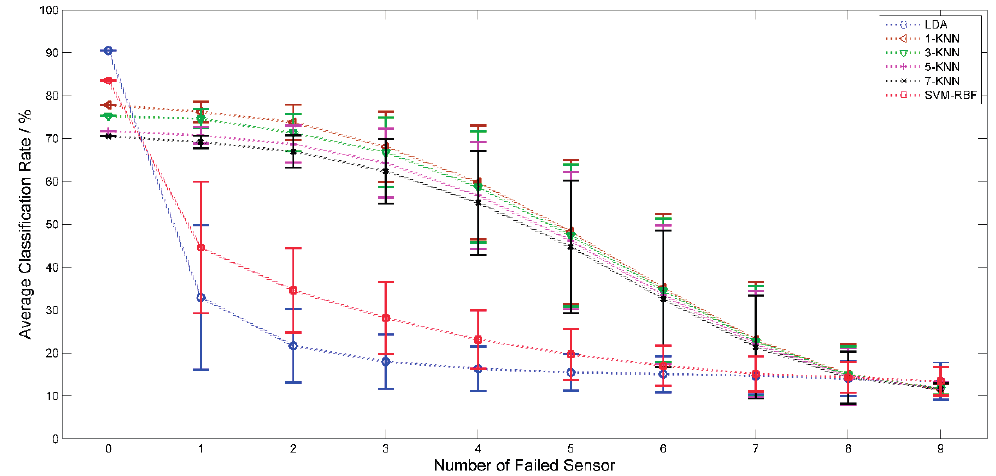
Figure 7. The mean standard deviation of classification accuracy with increasing number of failed sensor for LDA, SVM-RBF and KNN ( k = 1, 3, 5,